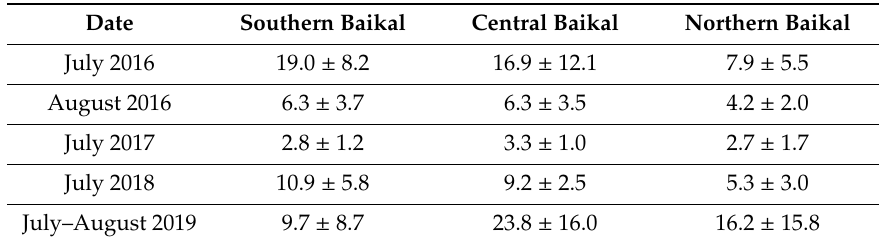
Table 2. Average mass concentrations of aerosol above the Baikal basins in summers from 2016 to 2019, µ g / m 3 .